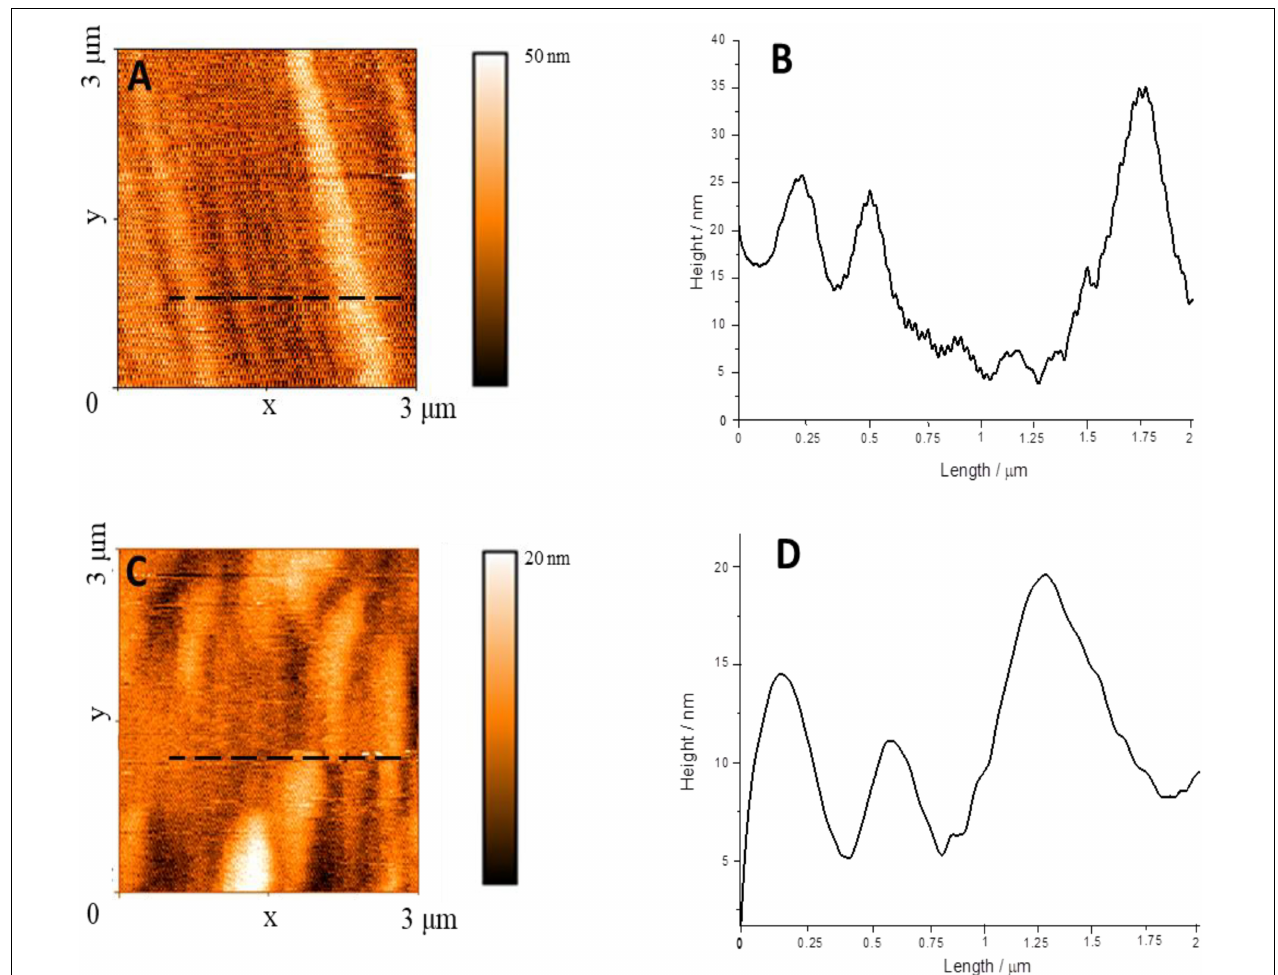
FIGURE 4 | (A) AFM image of D-PBI on silicon substrate; (B) Line profile recorded along the black dotted line in box (A) ; (C) AFM image of a cast film of D-PBI after the interaction with D-phenylalanine; (D) Line profile recorded along the black dotted line in box (C)